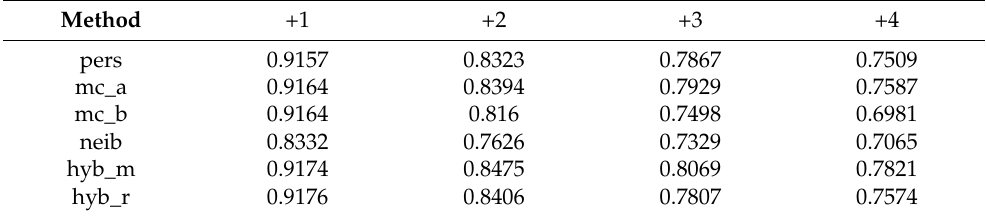
Table A1. Correlation coefficients of predicted and actual cloud modification factor (CMF) time series for 4 lead time steps (+1 to +4) in 2020 for Athens.